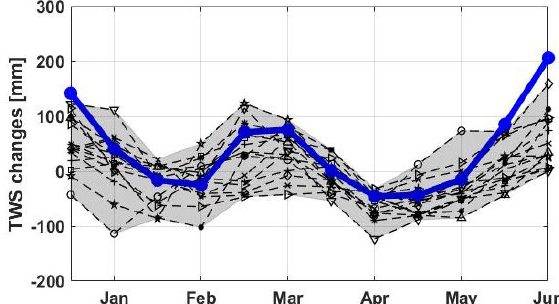
Figure 5. Average water storage changes for each month from 2002 to 2018; each year is represented by a black dashed line and different symbols (shaded grey area shows the range of variations). The blue line indicates water storage change for the 2019–2020 period, showing a higher than normal TWS increase compared with the previous